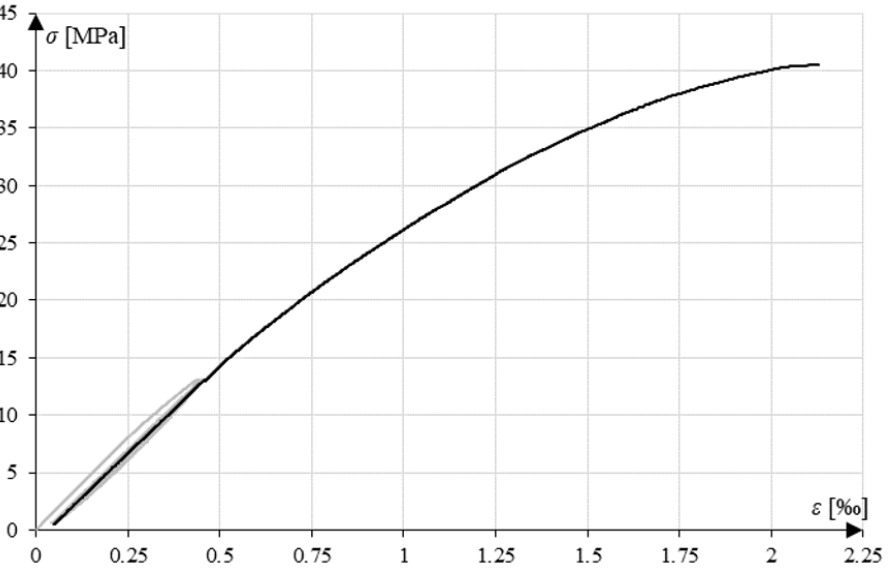
Figure 8: Stress–strain diagram for specimen tested according to method